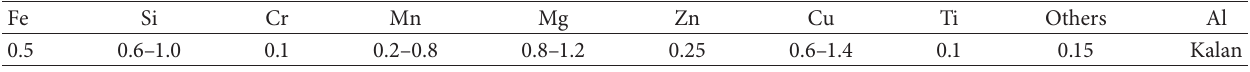
Table 1: Chemical compositions of AA 6061 alloy.